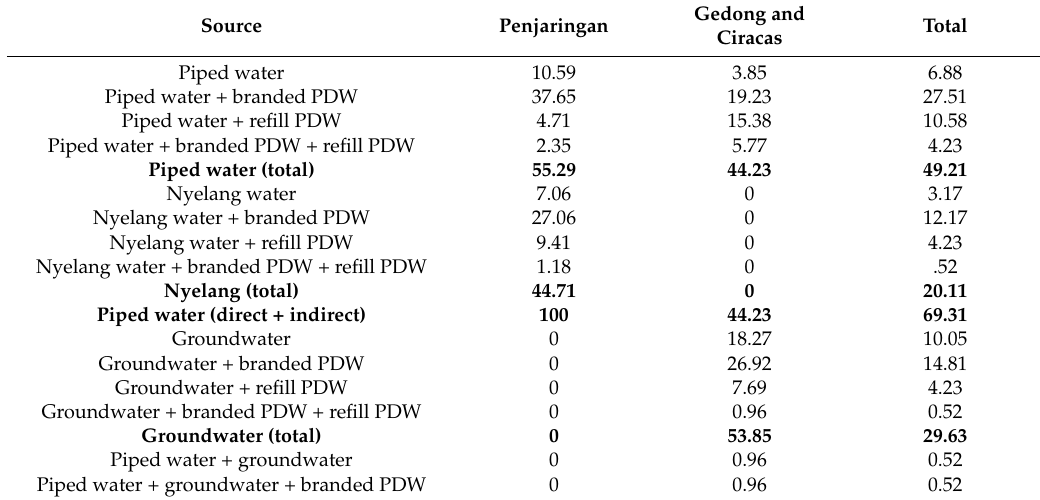
Table 3. Household water combinations, in percentages (Survey A). (Source: